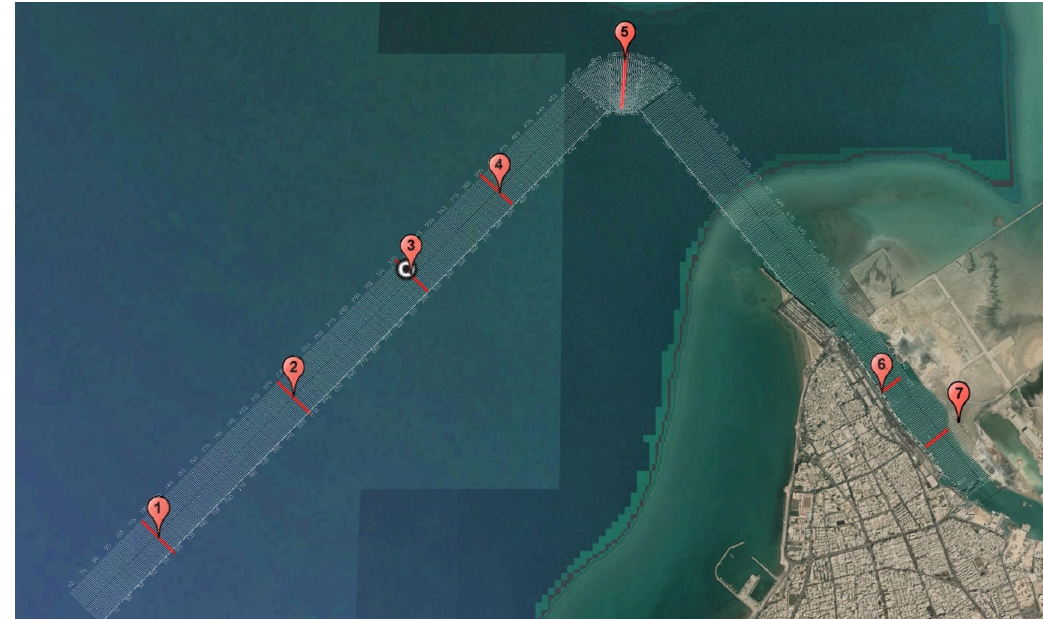
Figure 2. Locations of surface (7 points shown by numbered pin icons) and core (1 point shown by circle placemark icon) sediment sampling, and selected lines of hydrographic survey with dual- frequency echo sounder (7 transects shown by red line) along the access channel of Bushehr Port.